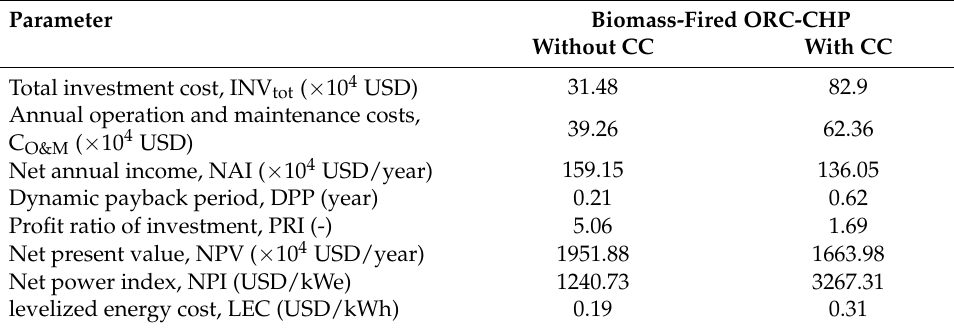
Table 15. Thermo-economic comparison of biomass-fired ORC-CHP system (R245fa) with and without CC (adapted from